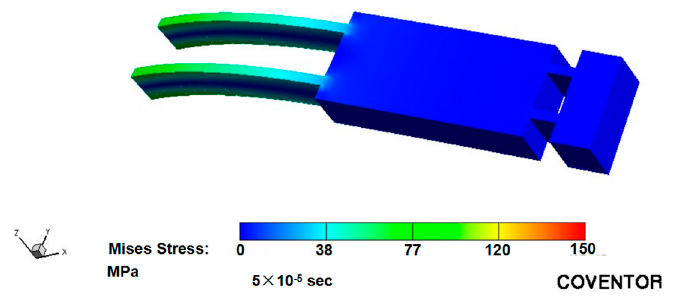
Figure 8. Variation of inertial stress.